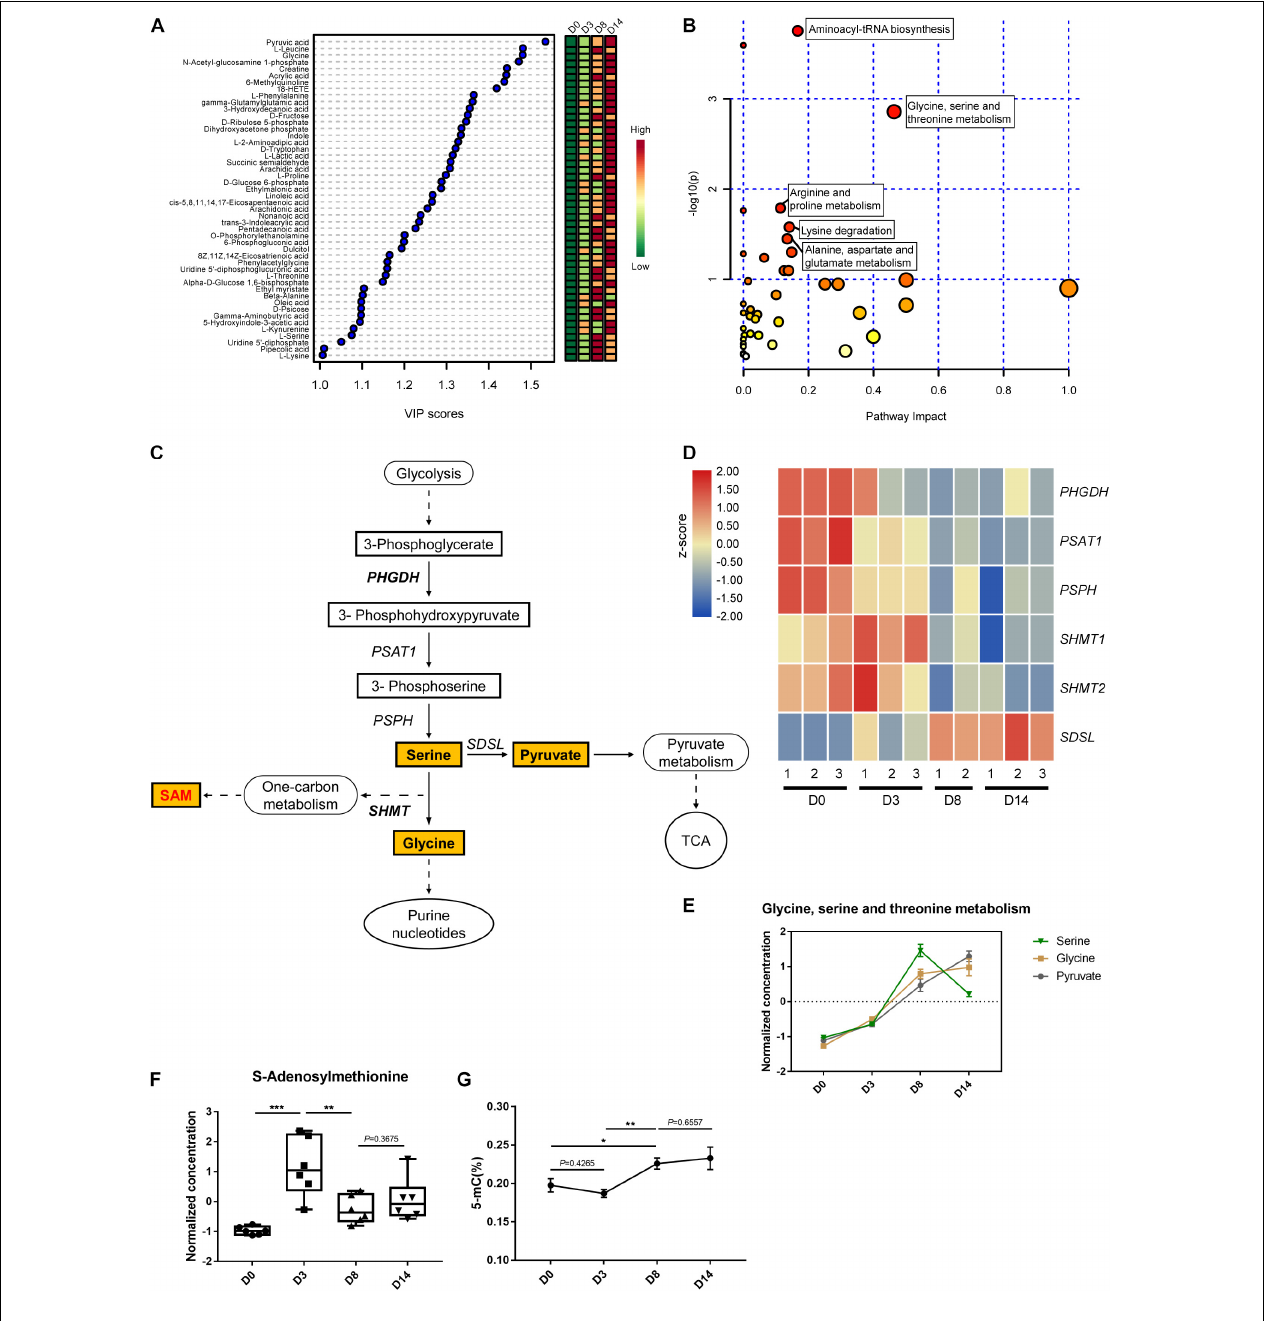
FIGURE 5 | Metabolic profiling of the glycine, serine, and threonine metabolic pathway. (A) Variable importance in projection (VIP) scores of 48 intracellular metabolites above one calculated by the PLS-DA model. Colors represent average concentration from six biological replicates at each time point. (B) Pathway impact analysis (pathways with high P -value and/or high pathway impact are labeled). (C) Schematic of glycine, serine, and threonine metabolic and related pathways. Quantified metabolites are highlighted. (D) Heatmap of the relative expression level of genes related to serine metabolism. (E) The normalized and auto-scaled concentration of measured metabolites in glycine, serine, and threonine metabolism pathway. (F) The normalized and auto-scaled concentration of S-Adenosylmethionine (SAM) in different time points. (G) DNA methylation level during the kidney organoid differentiation process. The normalization of concentration of metabolites is described in methods. Data are presented as mean ± SEM from at least three biological replicates. * P < 0.05, ** P < 0.01, and *** P <